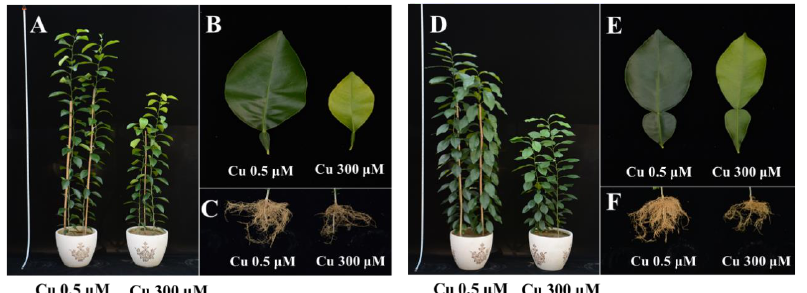
Figure 1. The effects of Cu toxicity on seedling growth ( A , D ), leaf morphology ( B , E ) and root development ( C , F ) of two citrus species ( C. sinensis : ( A – C ); C. grandis : ( D – F )).